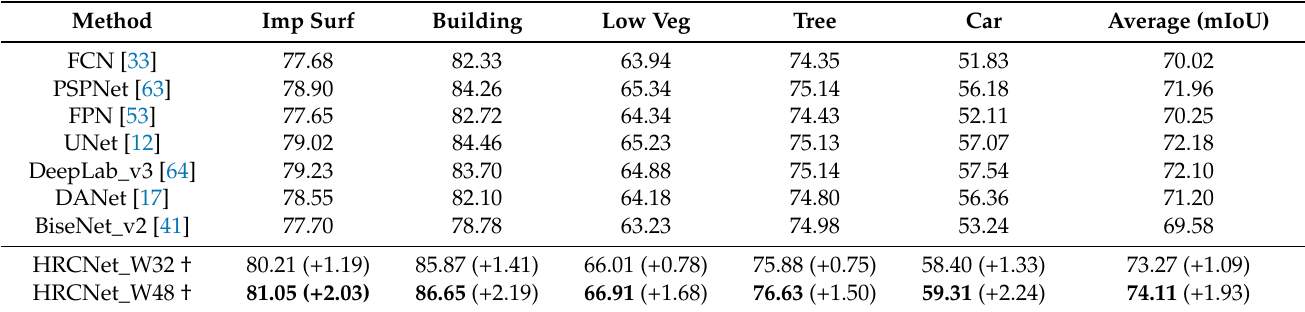
Table 9. Intersection over union (IoU) scores (%) of each category on the Vaihingen dataset, “†” means data augmentation (Flip and MS testing)